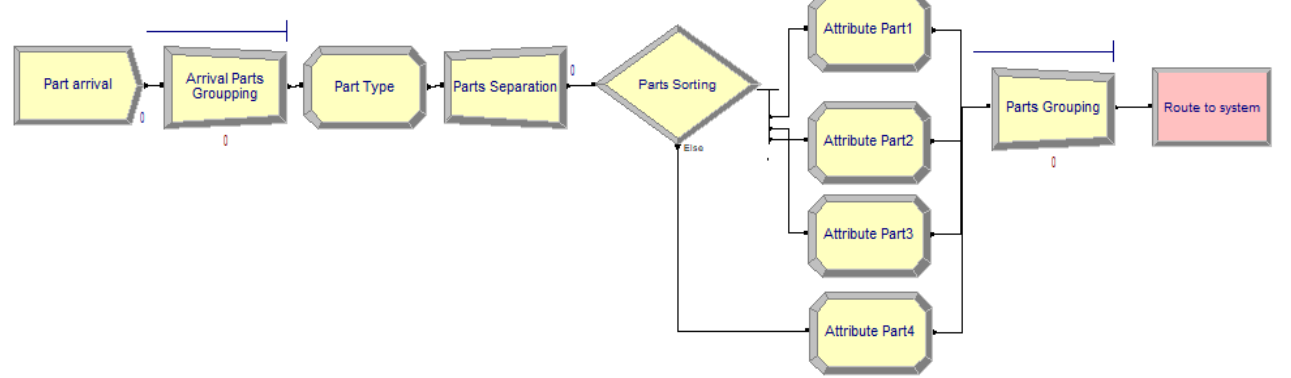
Figure 2. Simulation part model related to parts arriving.